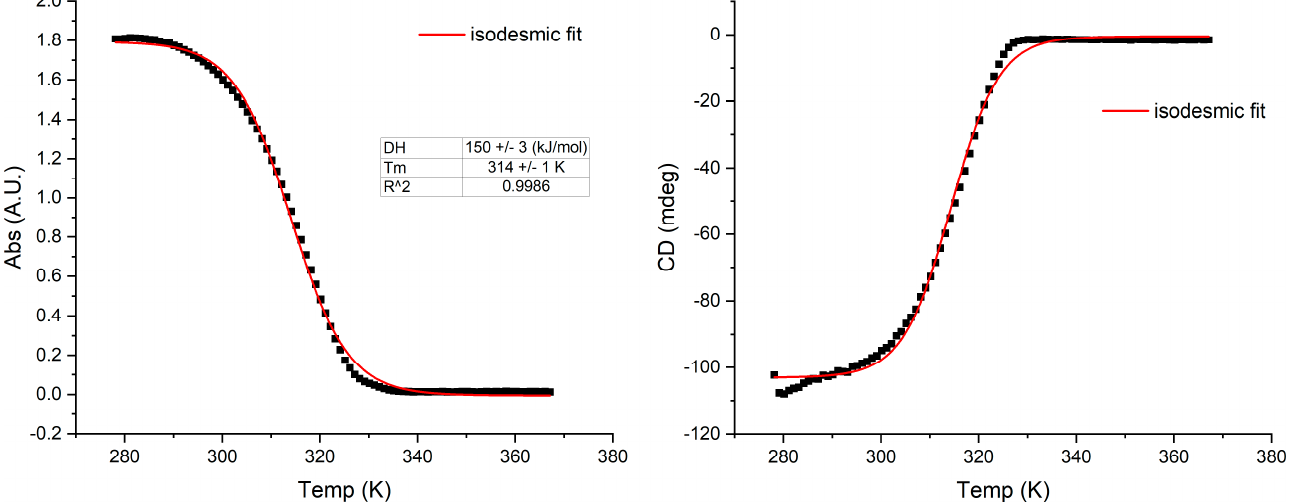
Figure 2. The melting curves of J- aggregates of S0271 at 20 µM in Milli-Q water; left: absorption, right: CD (pH 6.7, 18.2 Ω cm − 1 ) from clockwise stirring, monitored at 562 nm, recorded at 21 °C. The thermodynamic functions were calculated with an isodesmic polymerisation model, see methods. Δ H = enthalpy of association; Tm = melting temperature at which 50% of the aggregate is dissoci- ated.